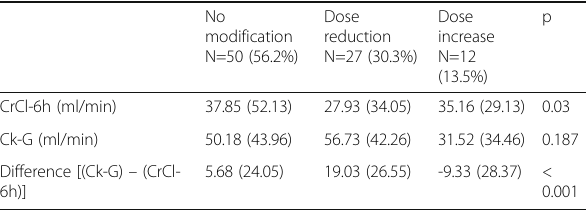
Table 1 (abstract 001212). See text for